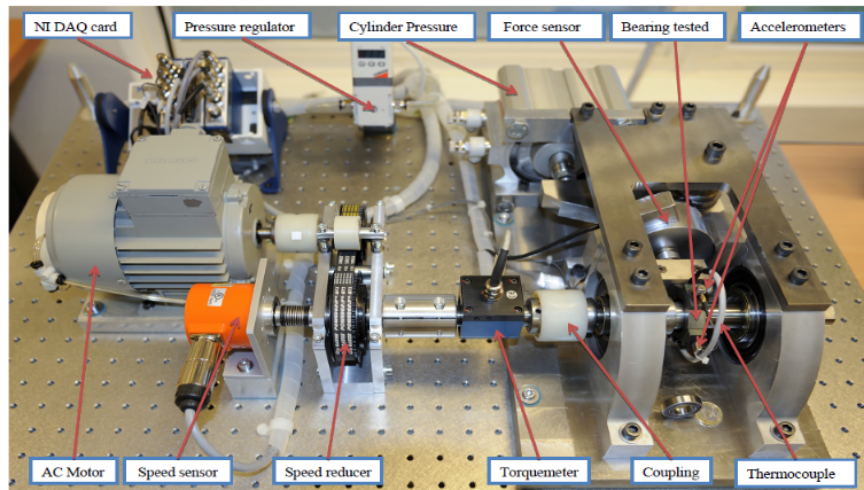
Figure 5. The PRONOSTIA platform for bearing accelerated degradation tests. The rotating part is driven by an AC motor. Acceleration sensors are placed on the tested bearing both on the horizontal axis and vertical axis. Cylinder pressure is placed to accelerate the degradation of the tested bearing.